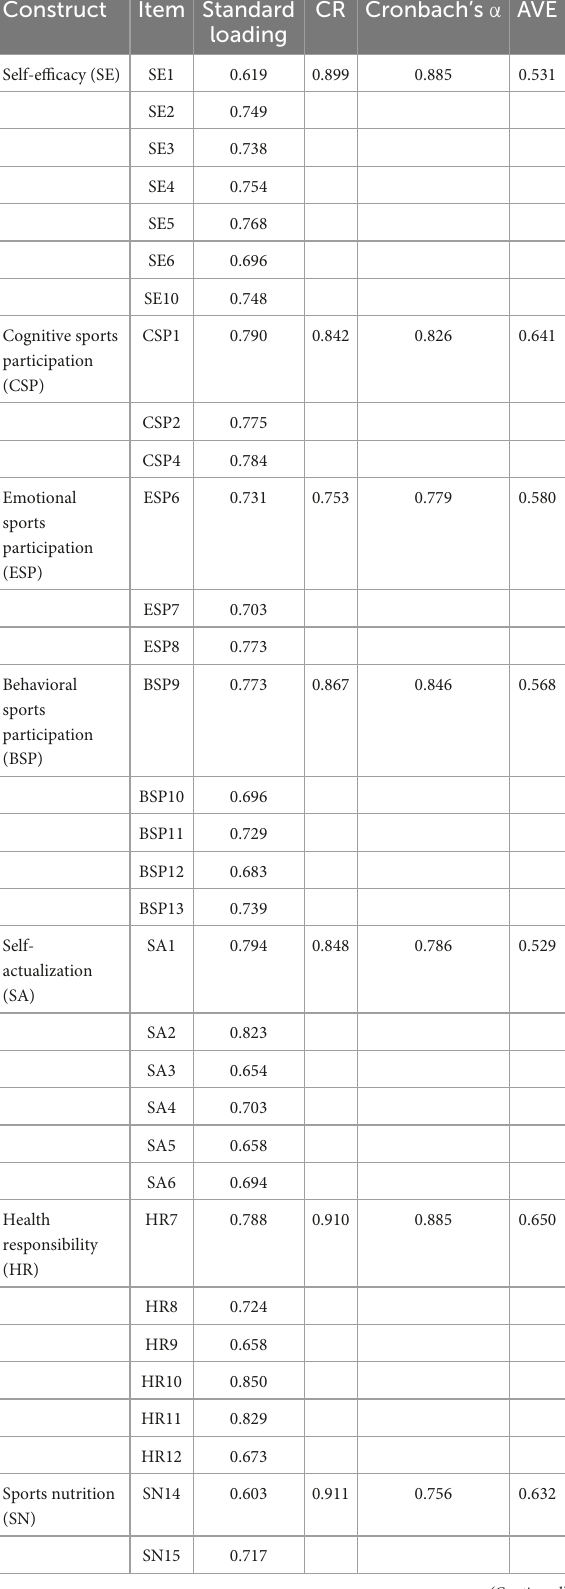
TABLE 3 Reliability and convergent validity of the study